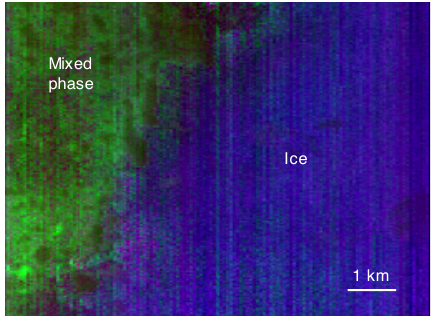
Figure 2. Typical fragment of a top-of-atmosphere reflectance image, drawn from Hyperion product ID EO1H2221282005350110KF over Ross Island, Antarctica, and displayed in visible red, green, and blue channels.